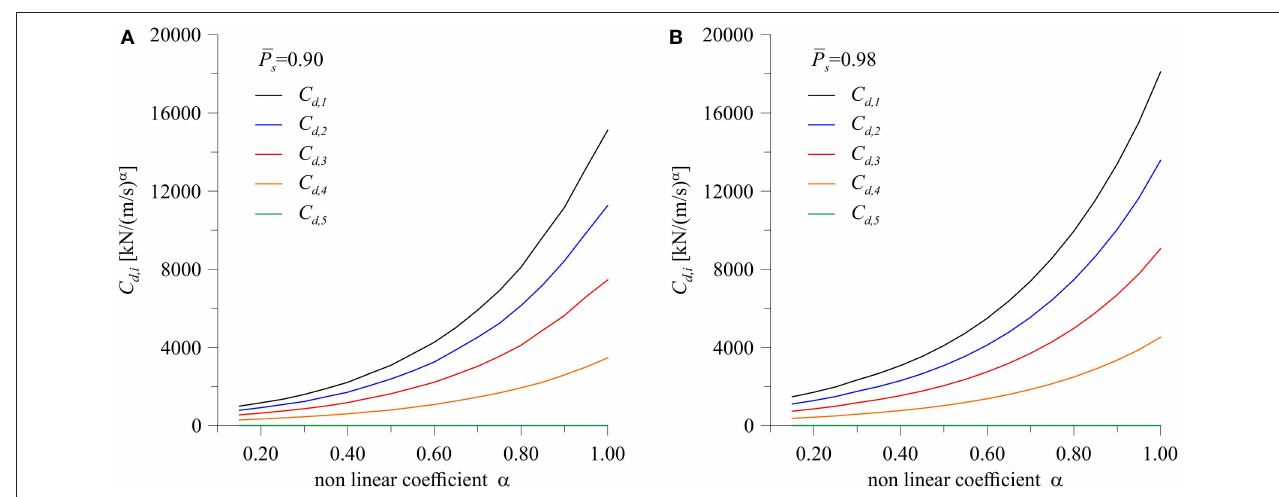
FIGURE 4 | Optimal pattern of viscous dampers. for (A) ¯ P s